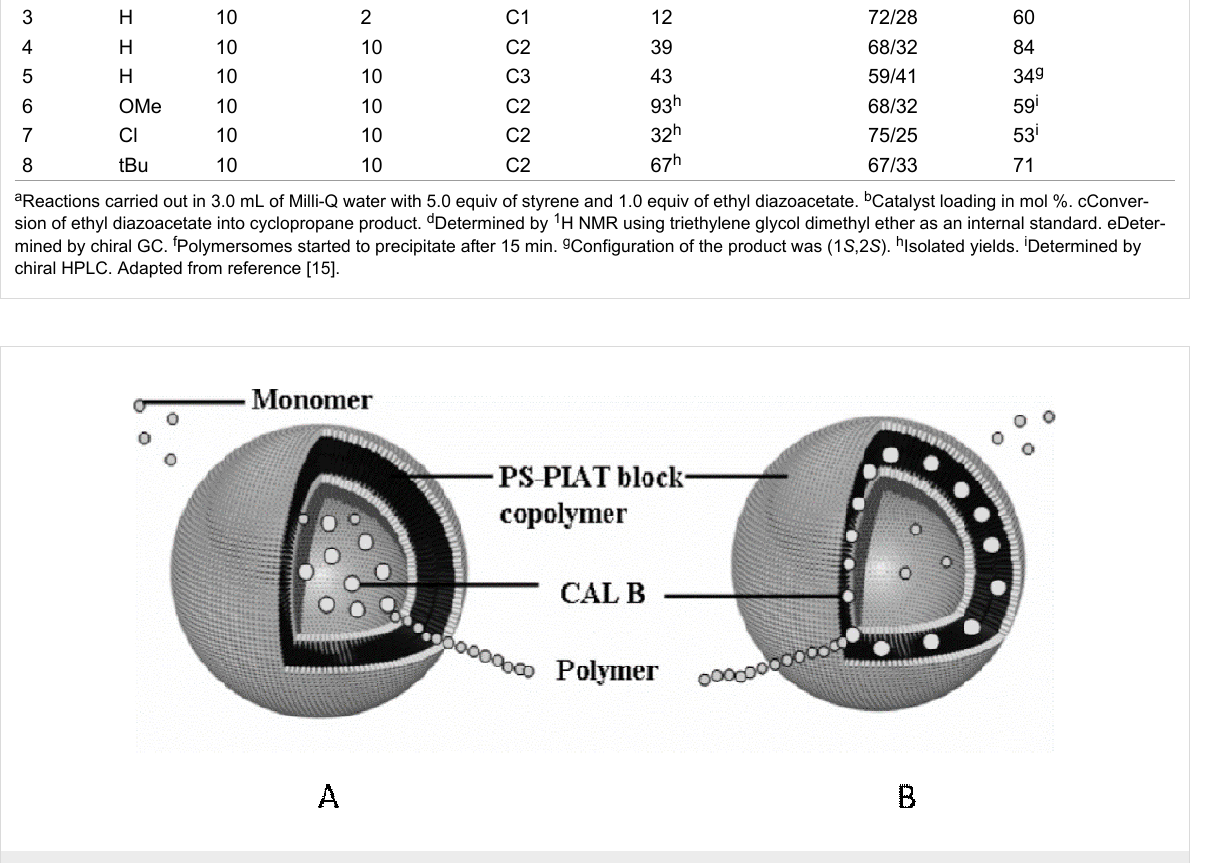
ROP is usually performed in organic solvent so that hydrolysis reactions can be avoided [17]. However, when nanoreactors were used, polymerization proceeded efficiently in water and without formation of any undesired products, providing a plat- form for aqueous ROP